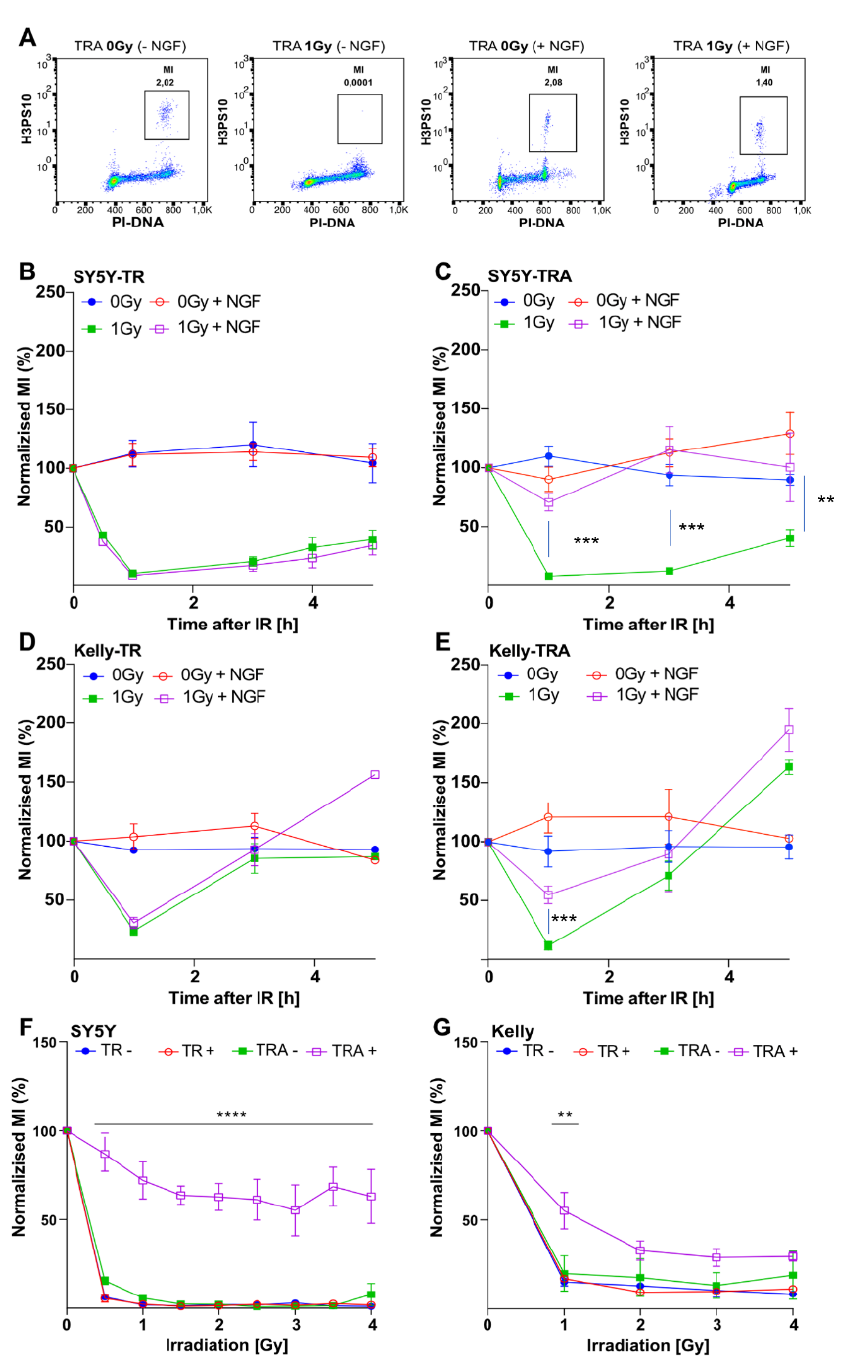
Figure 2. TrkA/NTRK1 activation abrogates the G 2 -checkpoint upon IR and induces a dose-independent G 2 checkpoint defect in both SY5Y-TRA and Kelly-TRA cells. ( A ) Representative dot plots indicate the mitotic cell fraction (mitotic index [MI], marked by squares), which was defined as the number of H3pS10-positive cell divided by the total number of cells at 1 h post IR. ( B ) SY5Y-TR cells and ( D ) Kelly-TR cells were exposed to IR (1 Gy) and the MI determined at time points indicated. ( C ) SY5Y-TRA cells and ( E ) Kelly-TRA cells along with their respective controls were exposed to IR (1 Gy) and their MI was determined at time points indicated. ( F , G ) Analyses of the mitotic index of SY5Y and Kelly cells after irradiation with IR doses as indicated. Asterisks indicate significant differences between irradiated cells with and without TrkA/NTRK1 activation as indicated (**** = p < 0.0001, *** = p < 0.001, ** = p < 0.01). Error bars show the SEM from three independent experiments.